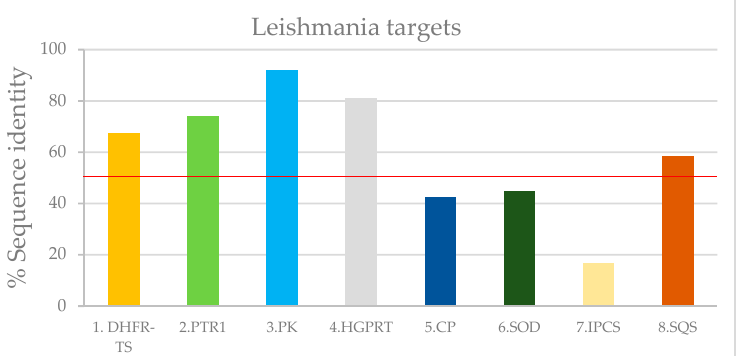
Figure A1. Leishmania targets with PDB ID according to their modeling identity value (based in Table A3). The lower limit of 50% for valid models is indicated with red line.